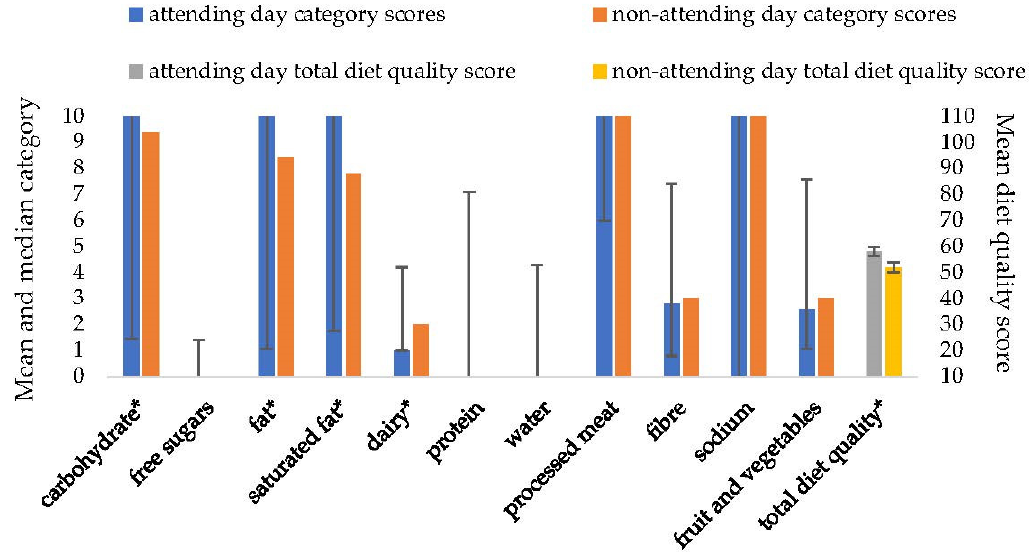
Figure 1. Mean (±SD) for total diet quality scores and mean (±SD) and median (IQR) for individual category scores across all participants ( n = 57). Statistically significant differences ( p < 0.05) are highlighted with *.